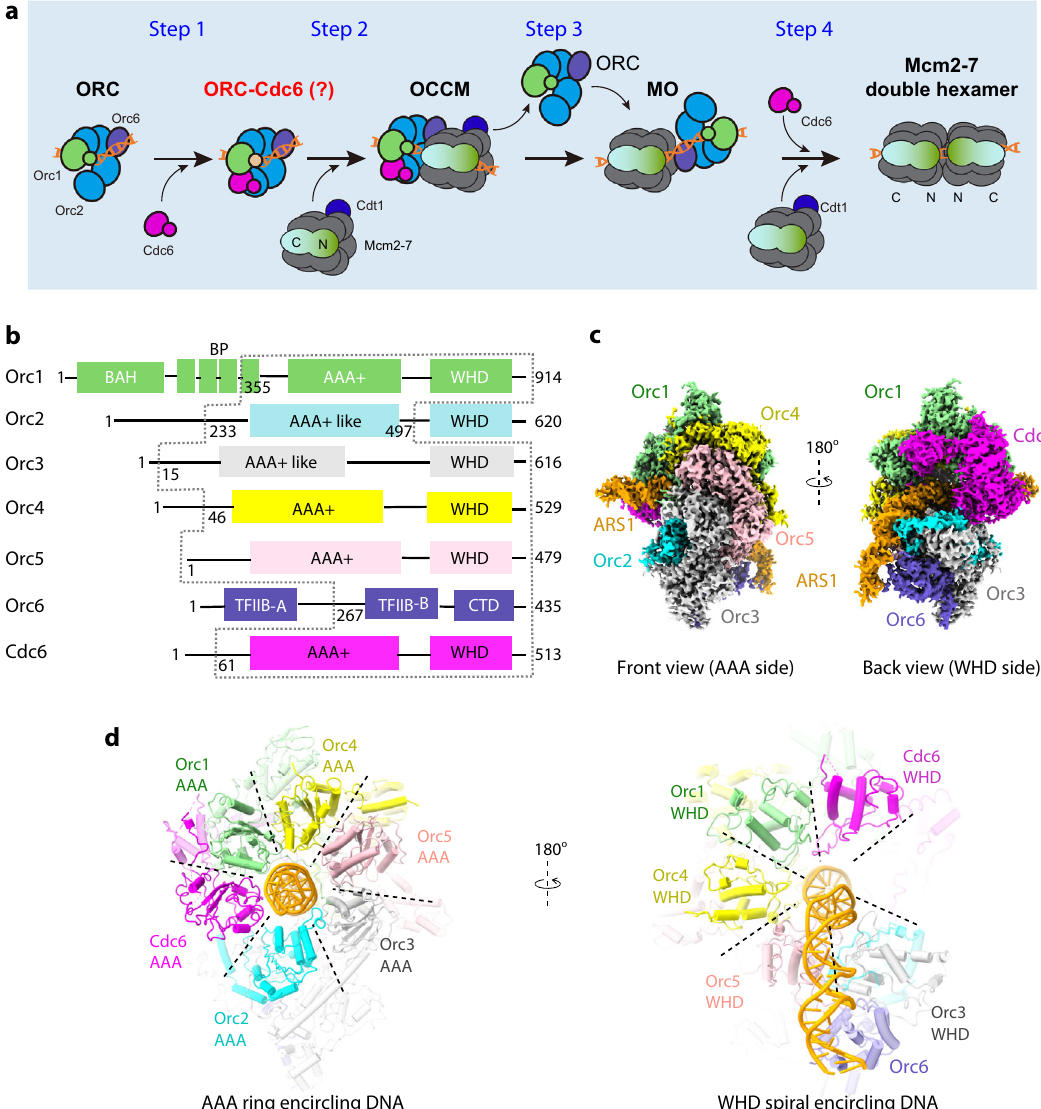
Fig. 1 Structure of the S. cerevisiae ORC – Cdc6 on the ARS1 origin DNA. a The four-step process of replication origin licensing from ORC – DNA. Only product 1, the assembly of ORC – Cdc6 on origin DNA was not understood at the molecular level. See the “ Introduction ” for details. b Domain organization of Orc1-6 and Cdc6. Regions modeled in the structure are enclosed by dashed gray lines. c Cryo-EM 3D map with individual subunits colored. d The six AAA + and AAA-like domains in ORC – Cdc6 nearly symmetrically surround the ACS element of the origin DNA (left), and the fi ve WHD domains spiral around the B1 element